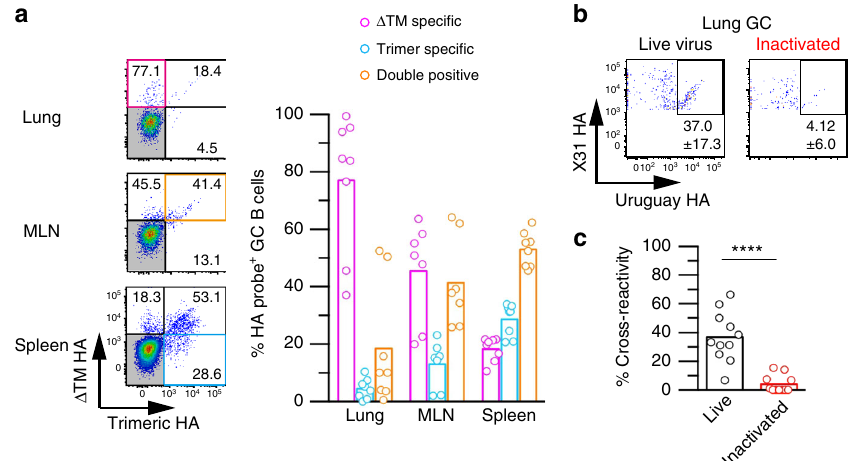
Fig. 3 Conserved epitopes are occluded in native trimeric HA. a GC B cells were gated on the indicated tissues from X31-infected mice (day 20) and used for the binding assay to Δ TM HA and trimeric HA. The percentage of GC B cells in three fractions ( Δ TM-speci fi c, trimer-speci fi c, and double-positive) were quantitated and plotted. Each circle represents the result from an individual mouse. The combined data from two independent experiments are shown. b Cross-reactivity was examined from lung GC B cells in the mice inoculated with live X31 virus or inactivated X31 virus. c Cross-reactivity was plotted from each group of mice. Each circle represents the result from an individual mouse. The combined data from three independent experiments are shown. The P -value was determined with a two-tailed Mann – Whitney test. **** P < 0.0001. Source data are provided as a Source Data fi